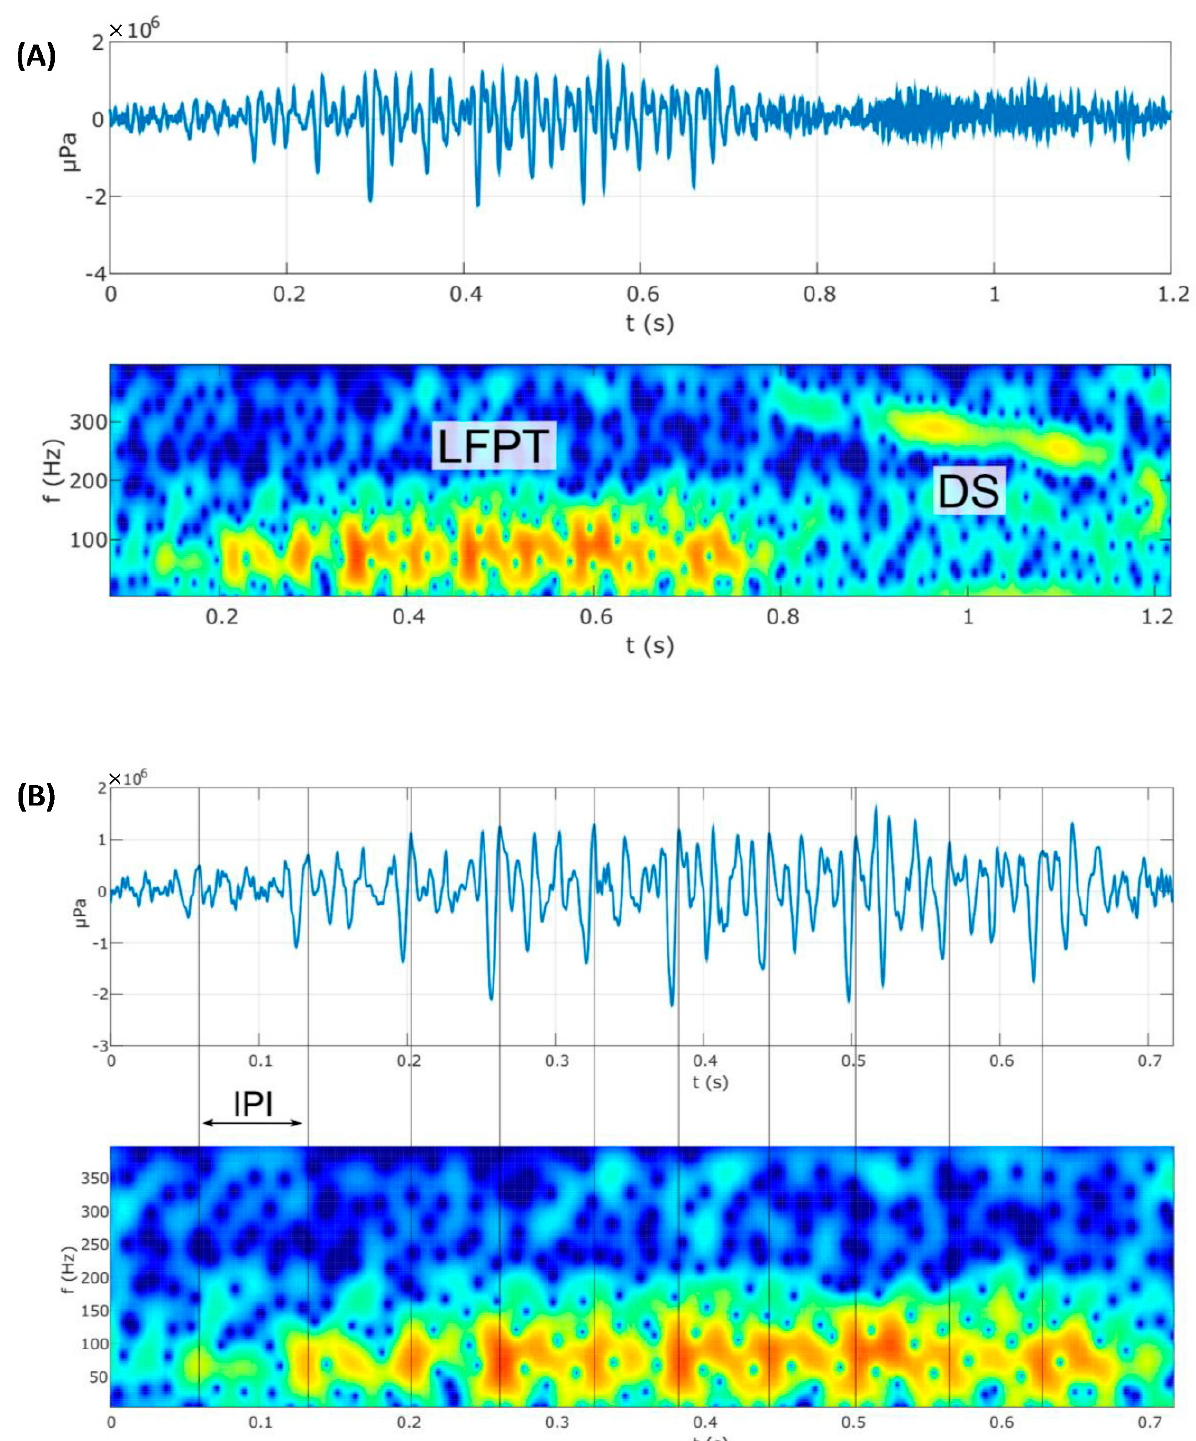
Figure 6. ( A ) Oscillogram ( top ) and spectrogram ( bottom ; fast-Fourier-transform (FFT) length = 256 samples/points, Kaiser window) of the two sound types presumably produced by the mottled grouper. LFPT: low-frequency fast pulse train; DS: downsweeping sound. The corresponding audio file is available in the Supplementary Materials. ( B ) Zoomed oscillogram ( top ) and spectrogram ( bottom ; fast-Fourier-transform (FFT) length = 256 samples/points, Kaiser window) of the LFPT sound. Vertical lines indicate pulse peaks (10 pulses). The inter-pulse interval (IPI) is the peak-to-peak interval and the time span from the first pulse peak to the last pulse peak was used to estimate sound duration.